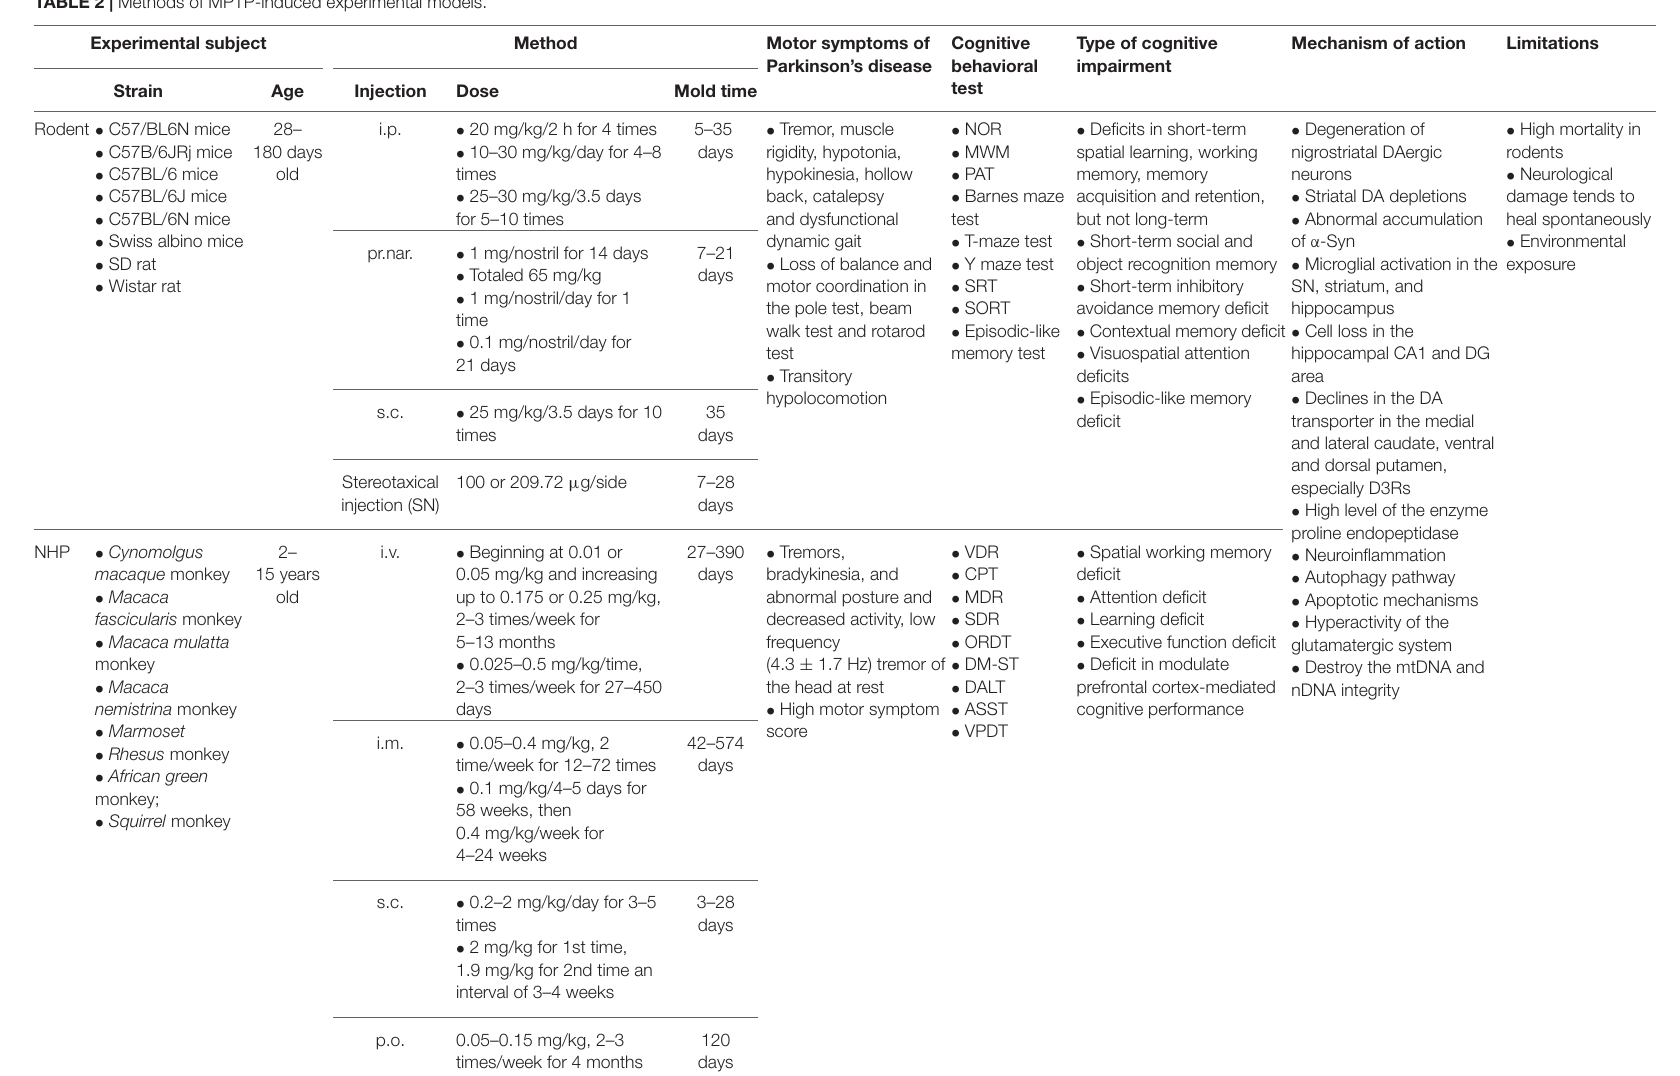
TABLE 2 | Methods of MPTP-induced experimental